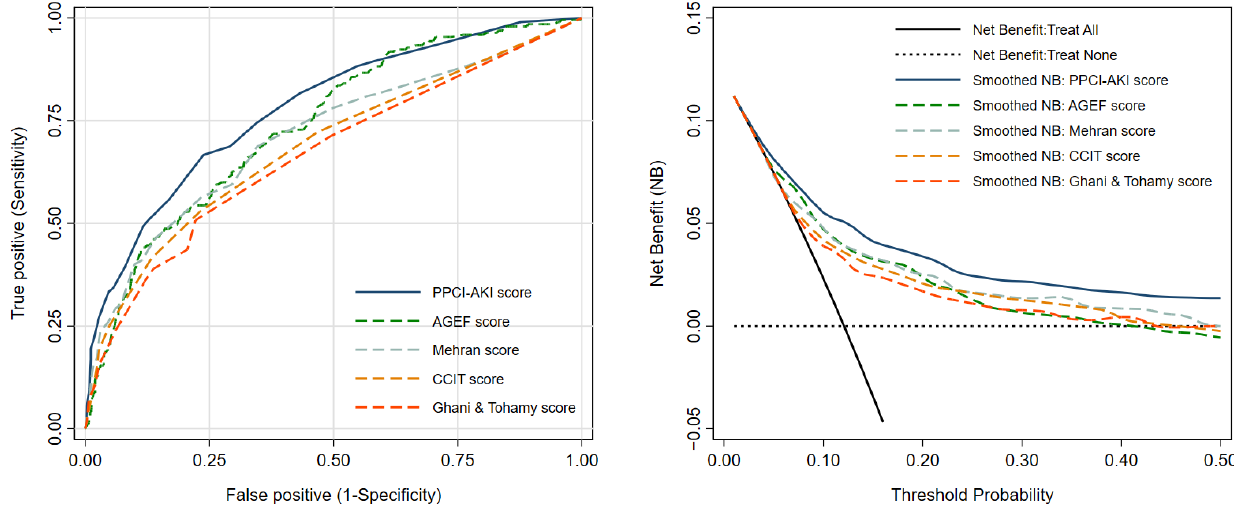
Figure 5. Comparative validation of the PPCI-AKI score to previously reported scoring systems in terms of discriminative ability (left) and clinical utility (right). Abbreviations: NB, net benefit; AGEF score, age, glomerular filtration rate, ejection fraction score; CCIT score, a score by central chest institute of Thailand.